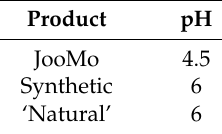
Table 4. pH of all products.